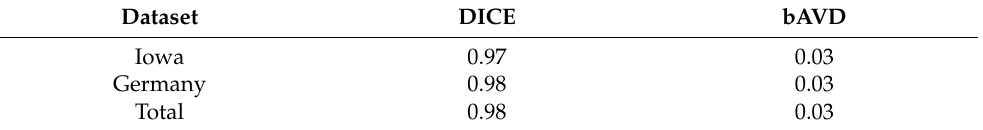
Figure 3. Intracranial volume mask visualization. Using both T1 and T2 weighted images simulta- neously, our model generated exceptionally high-quality masks that only differed from the ground truth in the posterior cutoff point, indicated by the red arrow. Table 4. DICE and balanced average Hausdorff distance results for intracranial volume model. DICE score indicates extremely high similarity to the ground truth images in both the Iowa and Germany datasets. Likewise, the low-balance average Hausdorff distance proves the accuracy of our model. Dataset